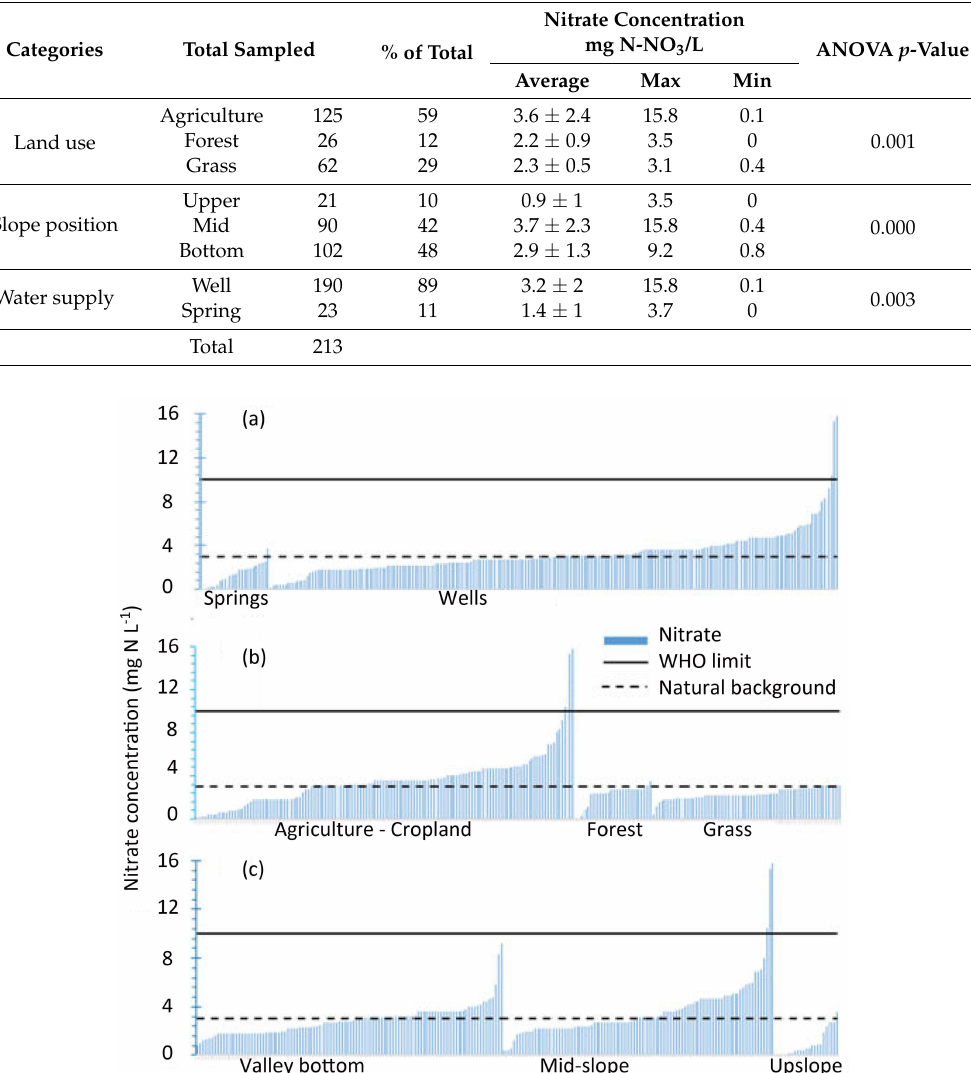
Figure 2. Nitrate concentration in South Gondar Zone sampled in the period from December 2013 to June 2014: ( a ) in springs and wells; ( b ) upstream land use; and ( c ) topographic position. The solid lines indicate the 10 mg/L WHO standard and the 3.4 mg/L natural